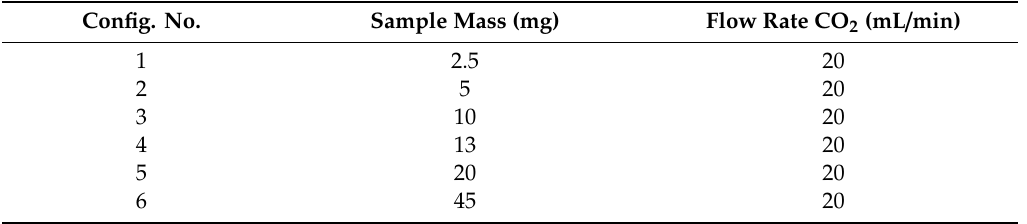
Table 4. Experiment configurations for determination of the sample mass influence; N 2 was added to yield a total gas flow of 100 mL /